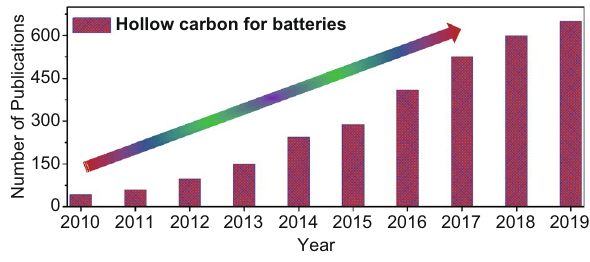
Fig. 1 Number of publications searched by using “hollow carbon materials for batteries” on the Web of Science in the past 10